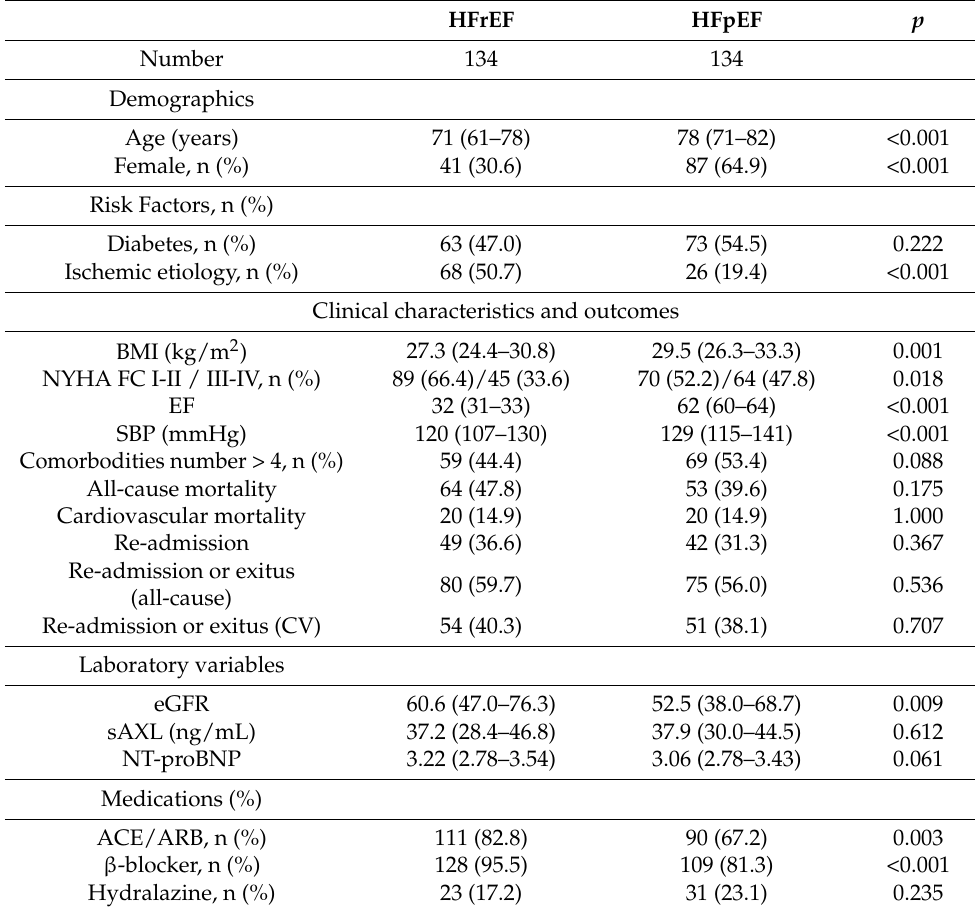
Table 1. Baseline characteristics of heart failure patients with reduced (HFrEF) and preserved (HFpEF) ejection